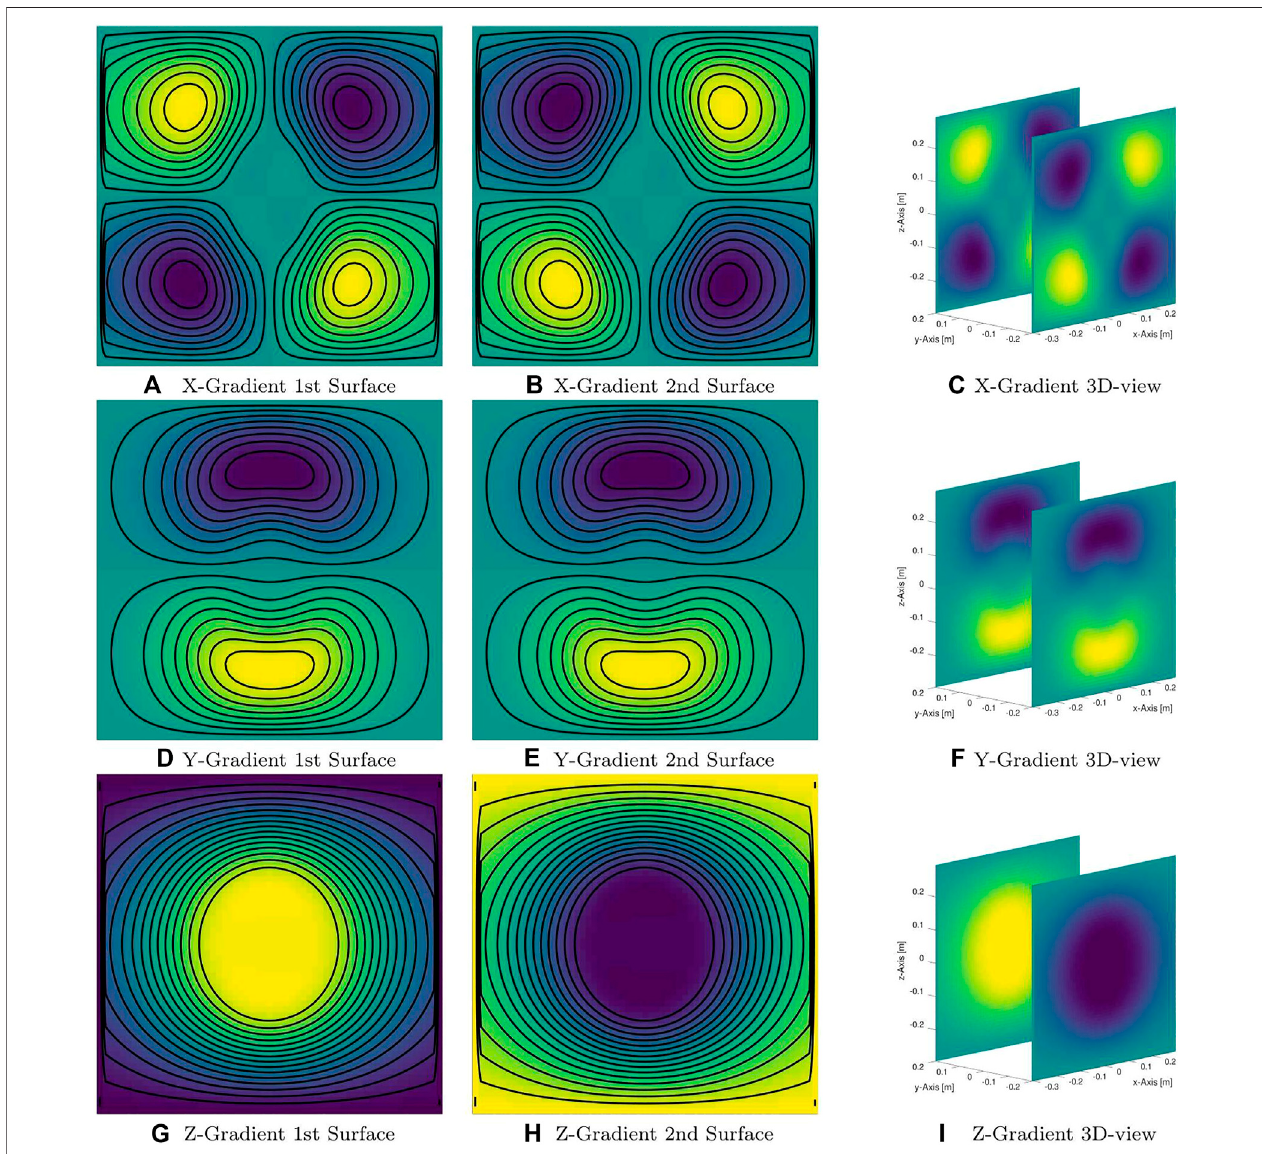
FIGURE 5 | Bi-planar design to demonstrate the feasibility of using fl at surface geometries. Direction of the main magnetic fi eld is along the z -axis. Both surfaces ( fi rst and second row) along with a 3D visualization are shown for three different gradient fi elds. Currents on all edges of both surfaces had to be forced to zero for achieving closed